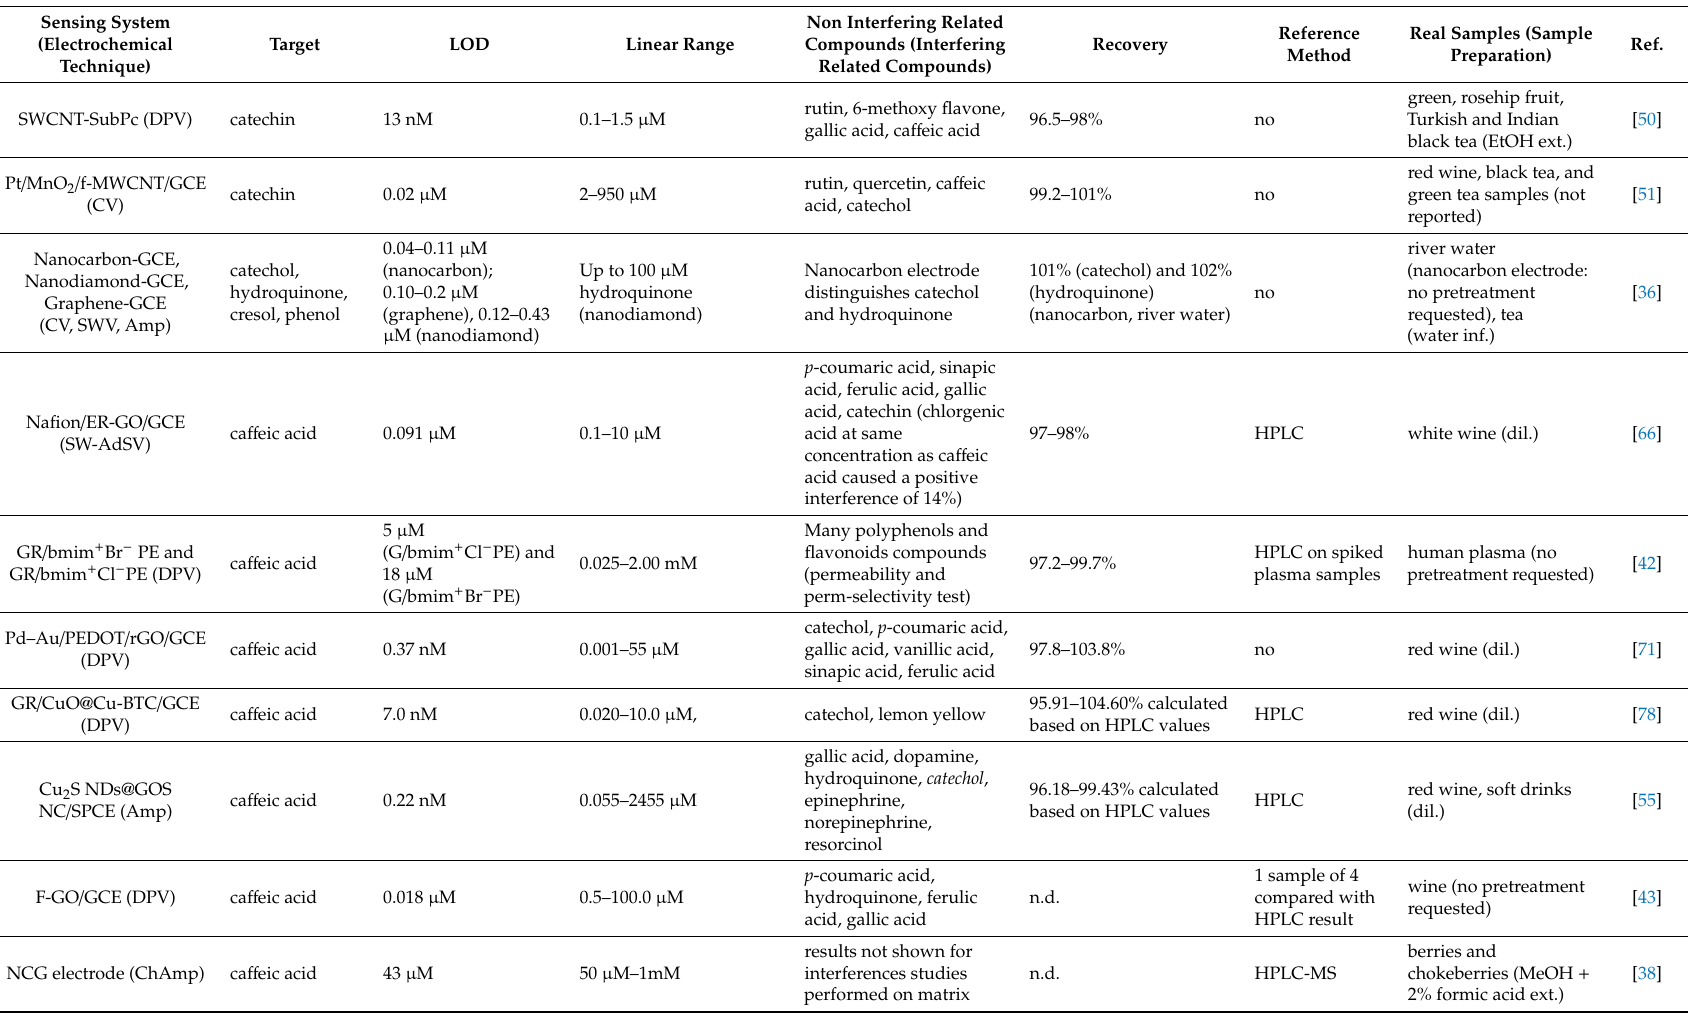
Table 1. Performance of electrochemical systems without recognition